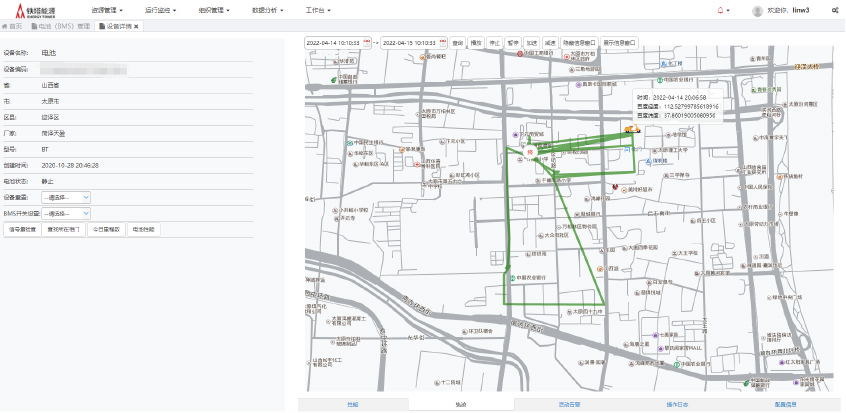
Figure 8. Battery management system (BMS). The usage state of the battery can be obtained from this